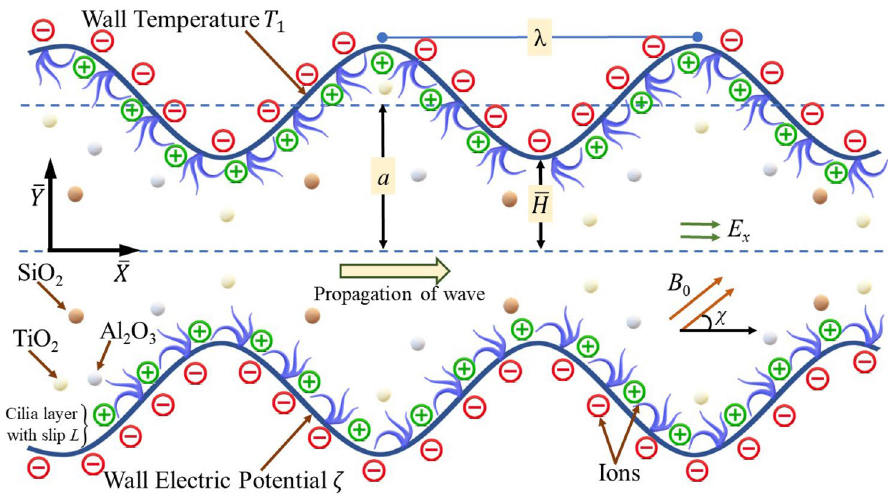
Figure 1. Geometrical model for cilia actuated electroosmotic transport of Carreau ternary